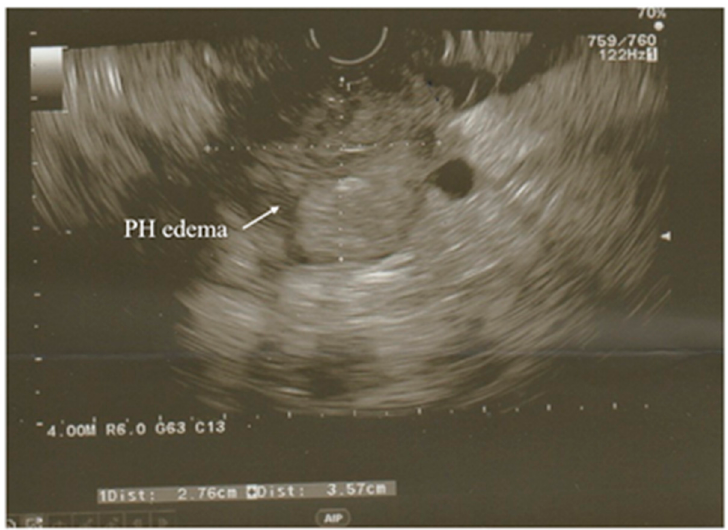
Figure 1. Acute pancreatitis with hypoechoic enlarged pancreatic head seen in EUS examination. PH—head of the pancreas.